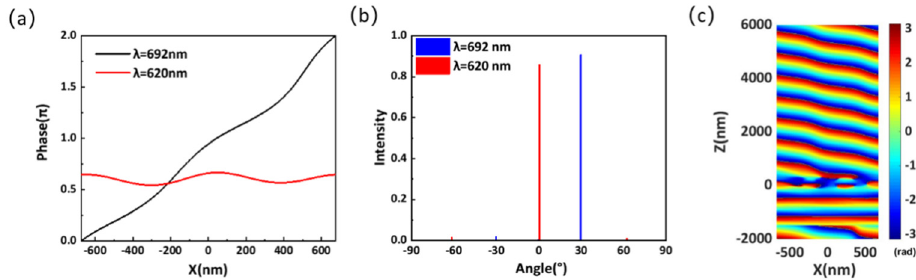
Figure 12. ( a ) Simulated phase distribution of the optimized structure along the x-direction at the wavelengths of 620 and 692 nm. ( b ) Far-field transmission intensity for different diffraction orders at the wavelengths of 620 and 692 nm. ( c ) Phase distribution of the optimized metasurface at the wavelength of 692 nm.